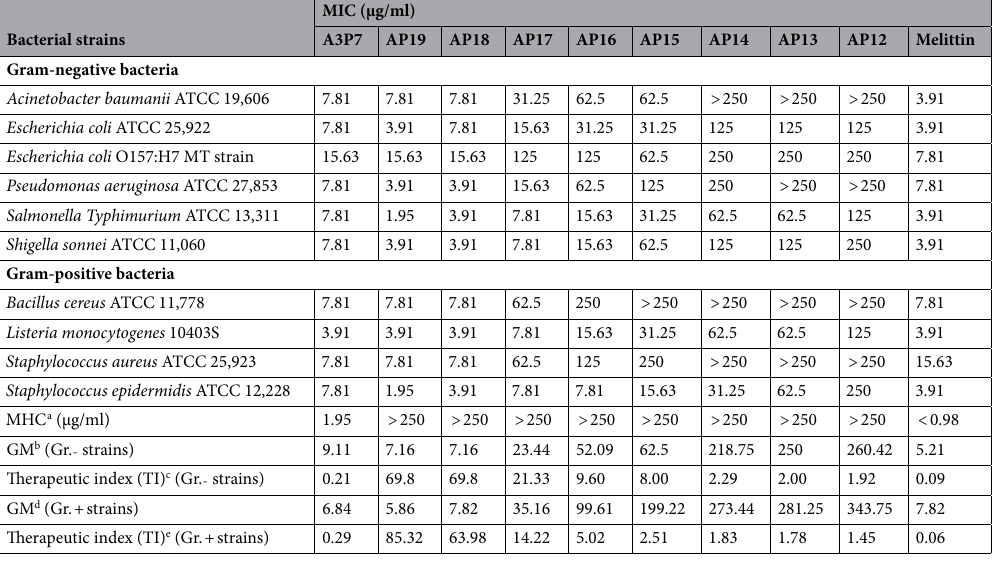
Table 2. Antibacterial activity, minimum hemolytic concentration (MHC), geometric mean of MIC value (GM) and therapeutic index (TI) of hybrid peptide derivatives. a MHC, minimum hemolytic concentration, indicated the peptide concentration that caused 10% hemolysis of human red blood cells (hRBC). When there was less than 10% hemolysis detected at concentration of 250 µg/ml, a value of 500 µg/ml was applied to calculate the therapeutic index. When there was less than 10% hemolysis detected at concentration less than 0.98 µg/ml, a value of 0.49 µg/ml was applied to calculate the therapeutic index. b GM (Gr.- strains) indicated the geometric mean of MIC value from all Gram-negative bacterial strains. When MIC was not detected at 250 µg/ml, a value of 500 µg/ml was applied to calculate the therapeutic index. c Therapeutic index (Gr.- strains) is the ratio of the MHC to the geometric mean of MICs from Gram-negative bacterial strains. d GM (Gr. + strains) indicates the geometric mean of MIC values from all Gram-positive bacterial strains. When MIC was not detected at 250 µg/ml, a value of 500 µg/ml was applied to calculate the therapeutic index. e Therapeutic index (Gr. + strains) is the ratio of the MHC to the geometric mean of MICs from all Gram-negative bacterial